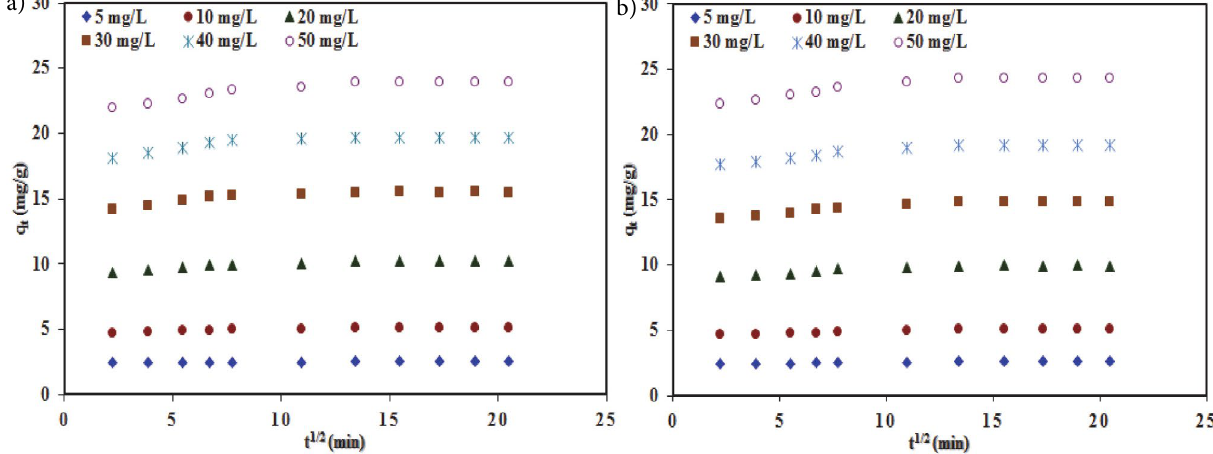
Figure 7. Intra-particle diffusion plots for the removal of MB (a) and MO (b) by GCM (MB/MO concentration = 5, 10, 20, 30, 40, and 50 mg/L, adsorbent dose = 2 g /L, pH 8 for MB and pH 6 for MO for, temperature = 25 °C). Table 3. Kinetic parameters of MB and MO sorption onto GCM at 25 °C (n = 3, the reported values are mean of three measurements). Dyes The initial q e , Th Pseudo-First-Order Pseudo-second-order Weber and